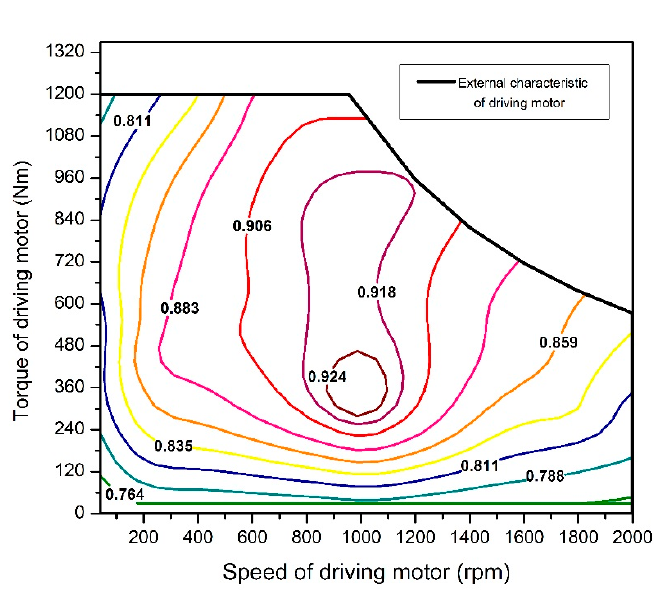
Figure 3. The efficiency map of driving motor.